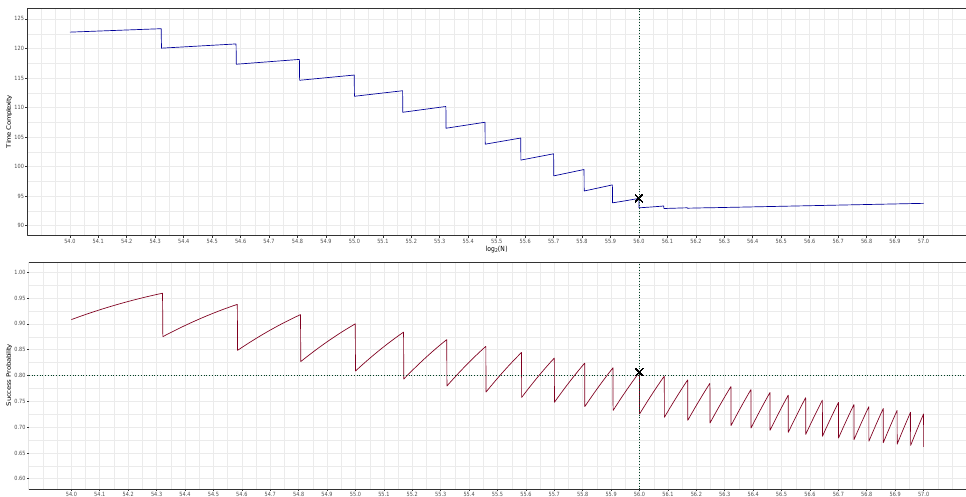
Figure 9: The relation curves of the attack. Since Υ (cid:28) N in our setting, we do not use Equation (19) and directly exploit the probability density function of the binomial distribution to estimate α and β